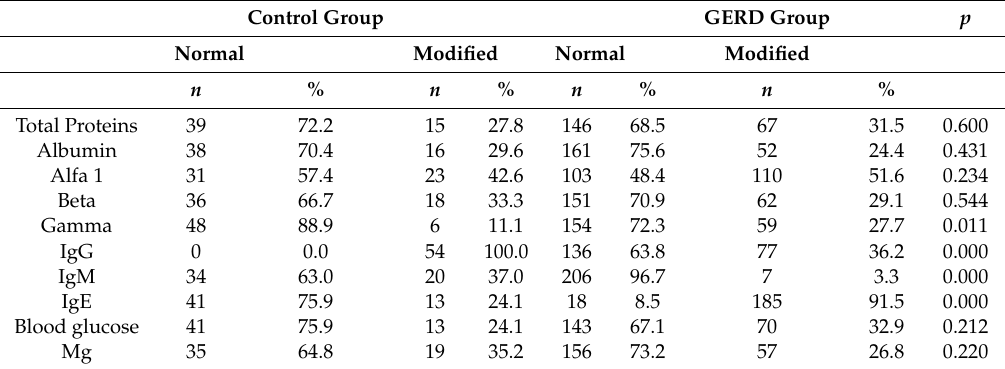
Table 4. Comparative study of ratios regarding patients with other modified parameters in the GERD group and the control